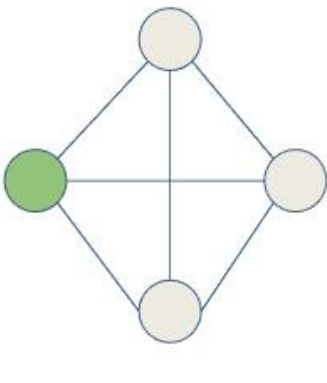
Figure 7. Visual representation of sanctioned exceptional